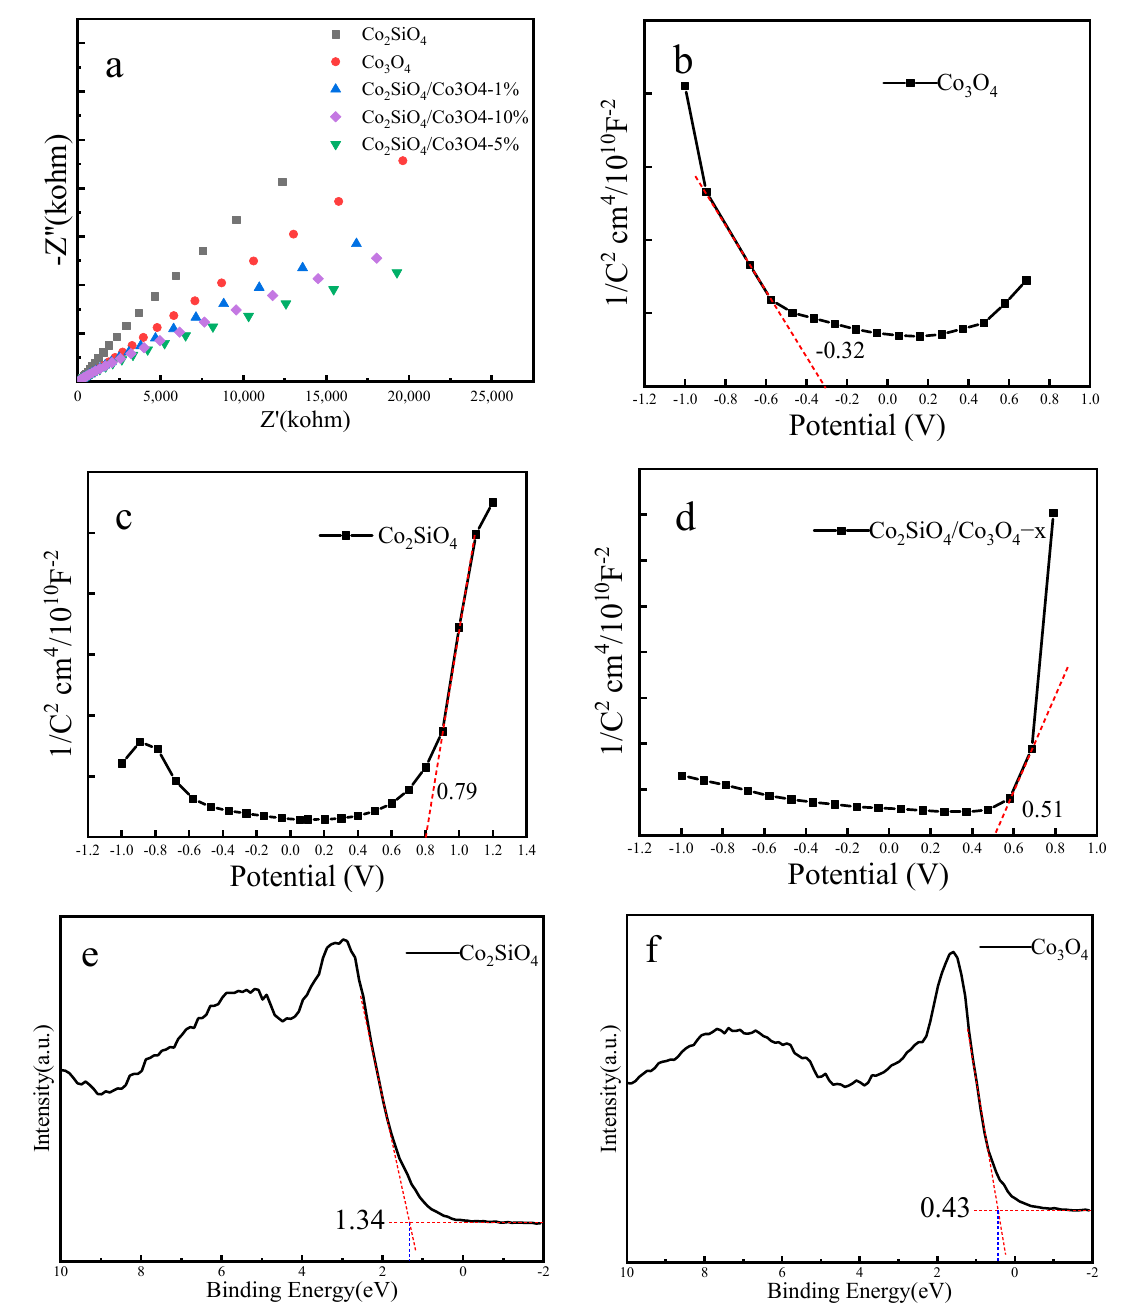
Figure 5. ( a ) Impedance spectra of Co 3 O 4 , Co 2 SiO 4 , and Co 2 SiO 4 /Co 3 O 4 − x; Mott − Schottky plot of ( b ) Co 3 O 4 , ( c ) Co 2 SiO 4 , and ( d ) Co 2 SiO 4 /Co 3 O 4 − x; VB-XPS of ( e ) Co 2 SiO 4 and ( f ) Co 3 O 4